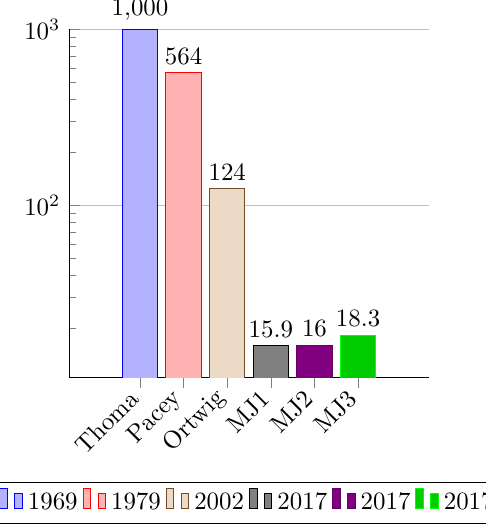
Figure 4: Model error, when optimizing model param- eters for variable displacement. Motor type is A6VM 71series size